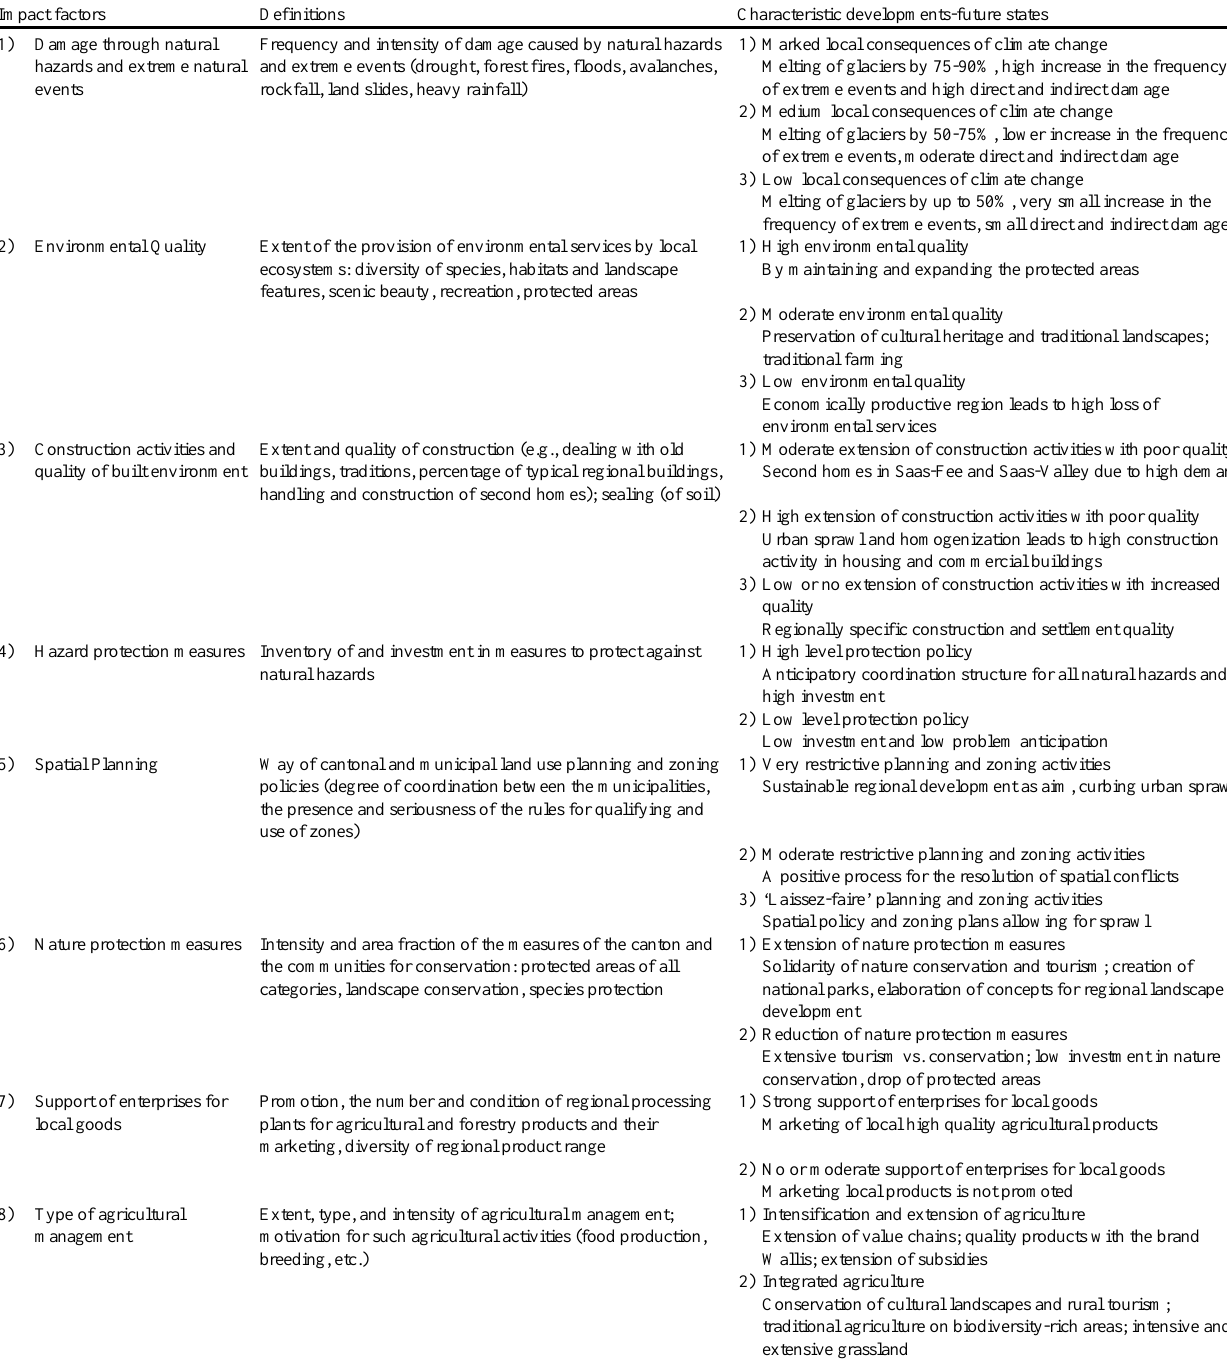
Table 2 . Impact factors of our study system with definitions and description of their respective future states. It is important to note that the impact factors differ in their complexity. Please also note that in a genuine formative scenario analysis (FSA) all future states are defined complementary to each other. We did not completely follow this approach in our study, particularly if future states are defined as a combination of aspects. In these cases, some of the future states may be partly